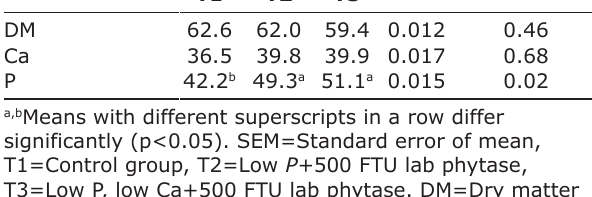
Table-5: Bone morphometry (left tibia) of broiler chicken on different dietary treatment. Treatment Bone weight (g/kg live weight)